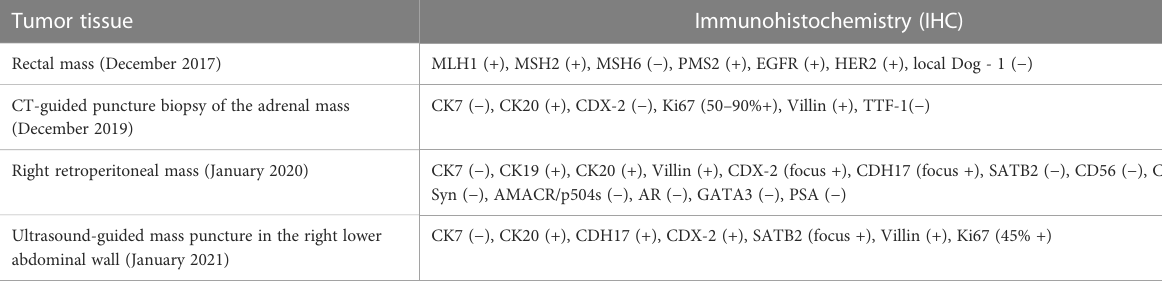
TABLE 1 Immunohistochemical results of four tumor tissues from the